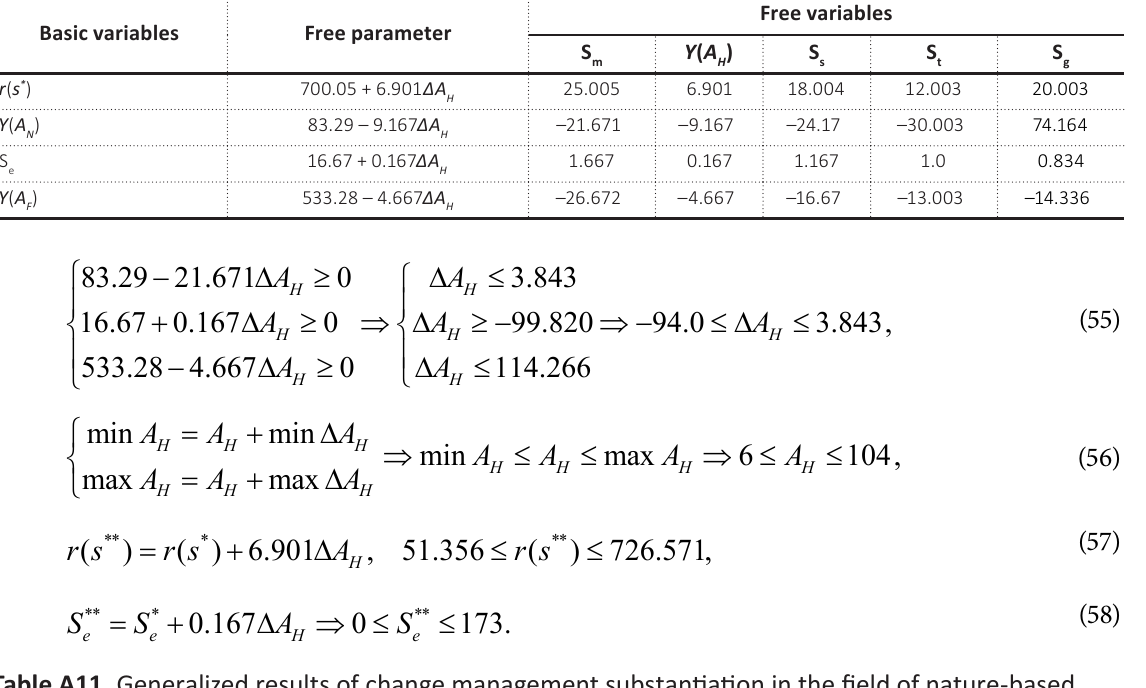
Type of tourism destination Health and “Wow effect” % Green % tourism tourism